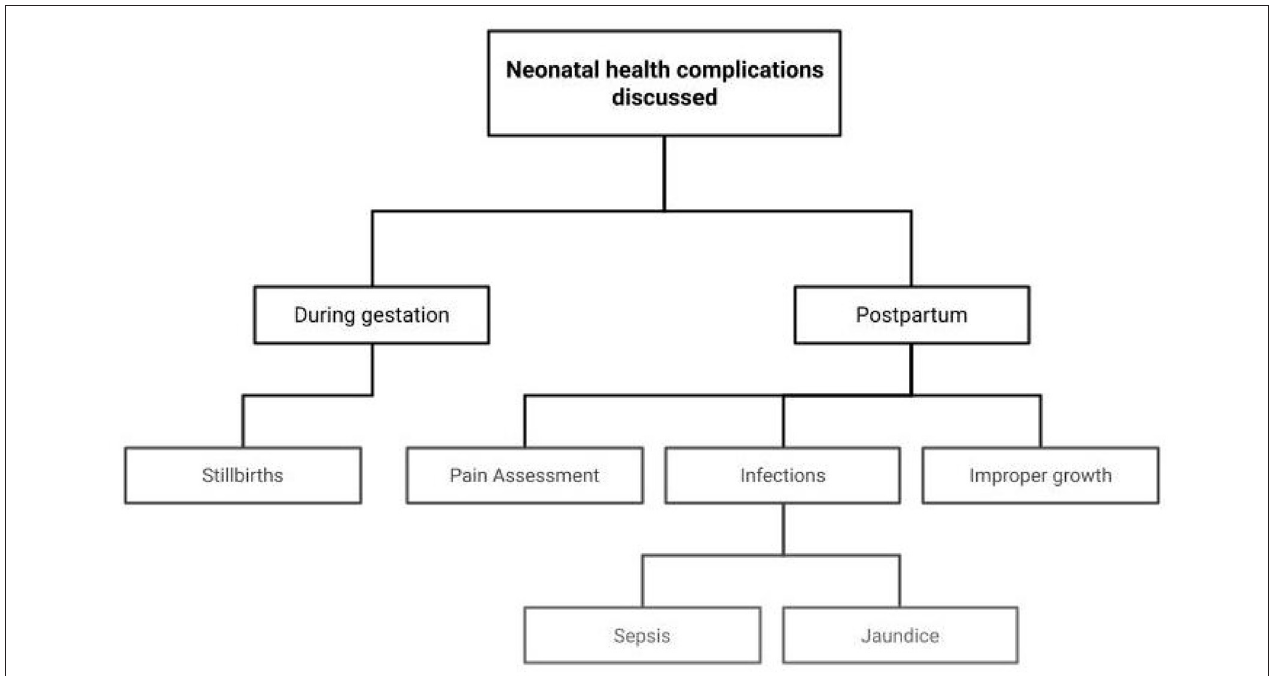
FIGURE 8 | Focus areas on role of AI in supporting Neonatal